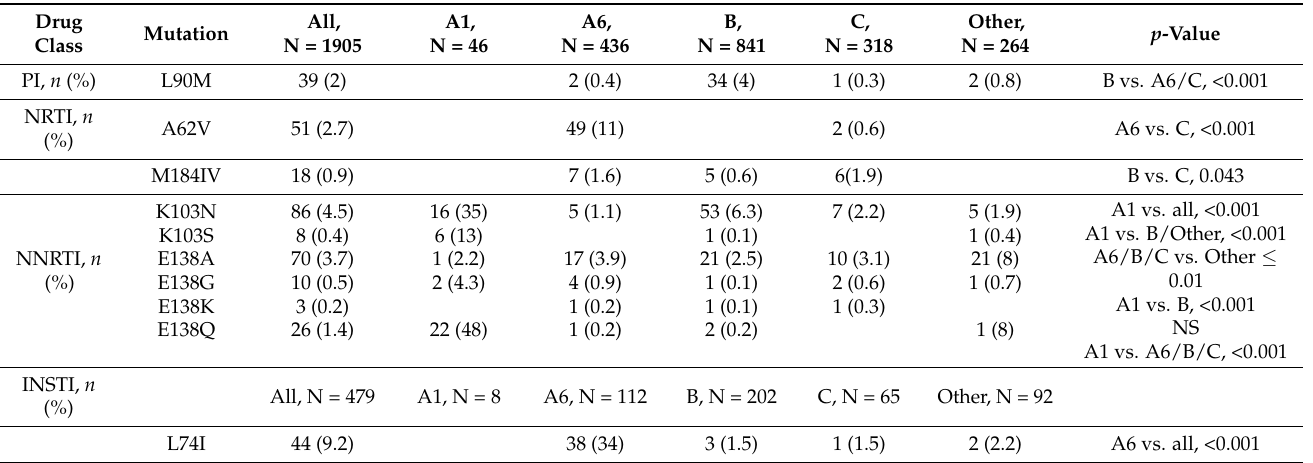
Table 3. Proportion of most frequently and/or clinically relevant detected resistance mutations in newly diagnosed people living with HIV-1 (PLHIV) in Israel